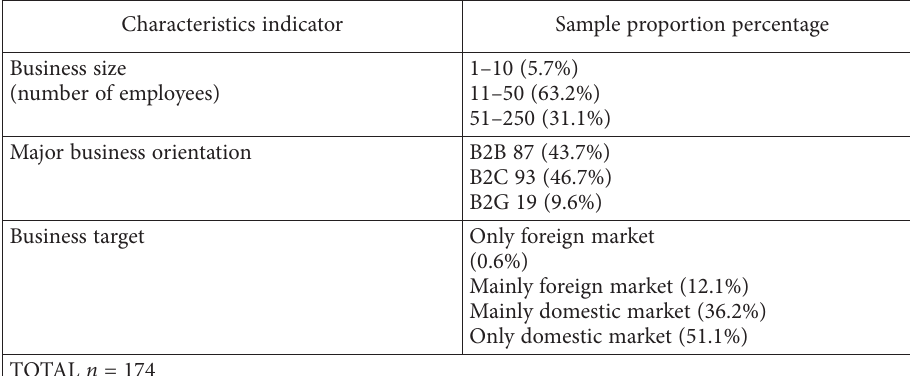
Table 1. Research file characteristics (source: created by authors) Characteristics